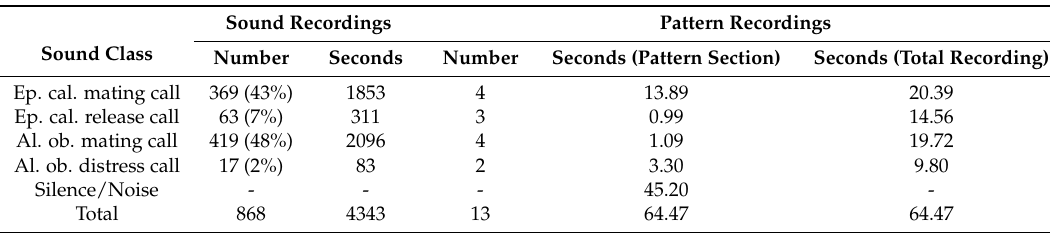
Table 1. Dataset of sounds and patterns.